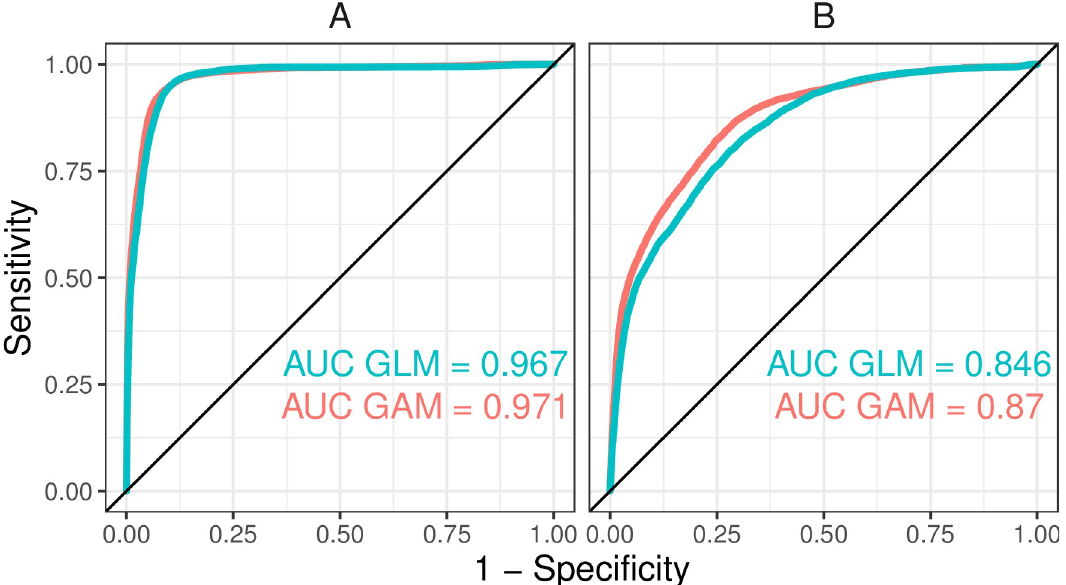
Fig 7. ROC curves and AUC values for the test of the snow damage probability map with the Forest Centre data: using non-damaged polygons from the whole country (A) and only considering non-damaged polygons within 10 km distance from snow damaged polygons